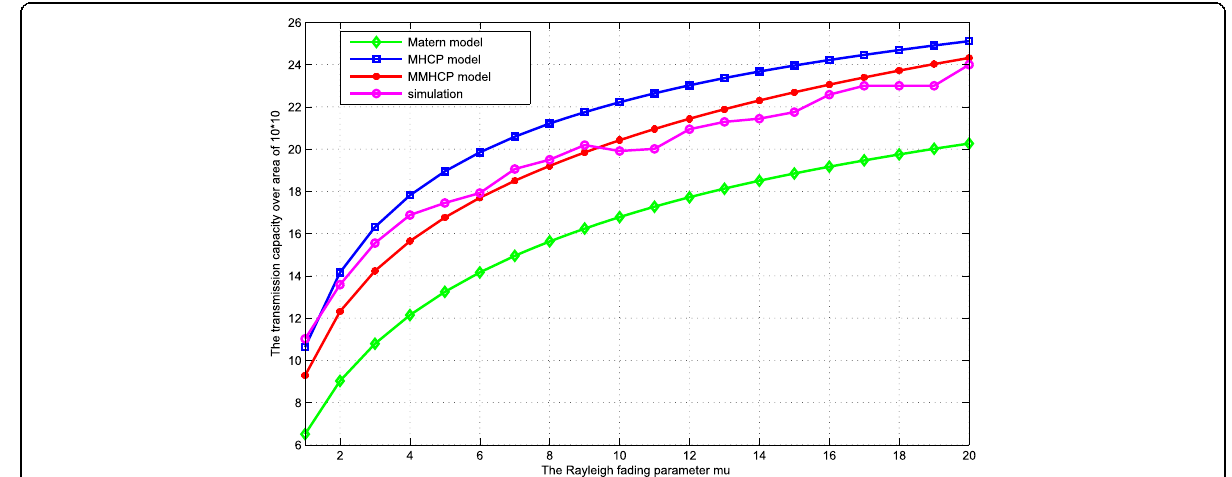
Fig. 14 Transmission capacity for different fading factor